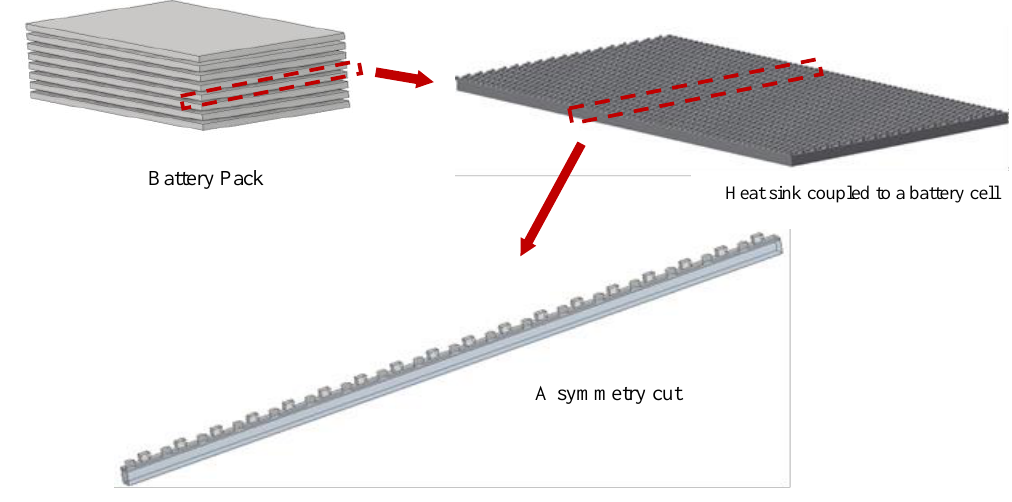
Figure 2. Thermal management system